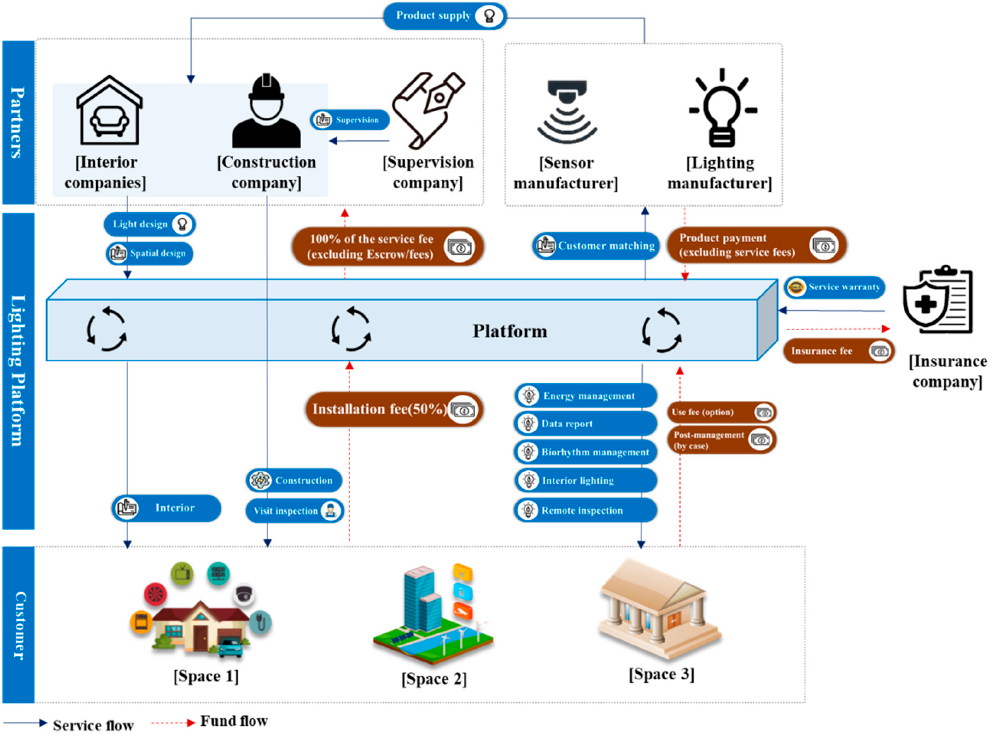
Figure 7. Billing Strategy for HCL BMC.